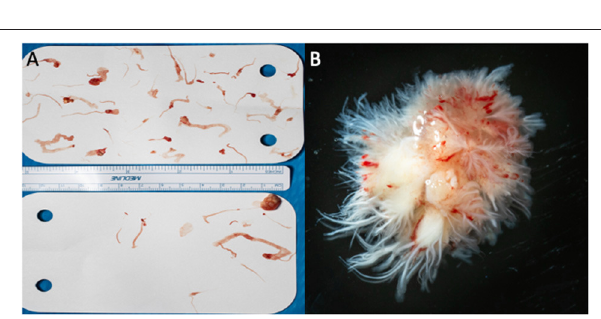
FIGURE 5 | (A,B) Gross pathology photographs of the